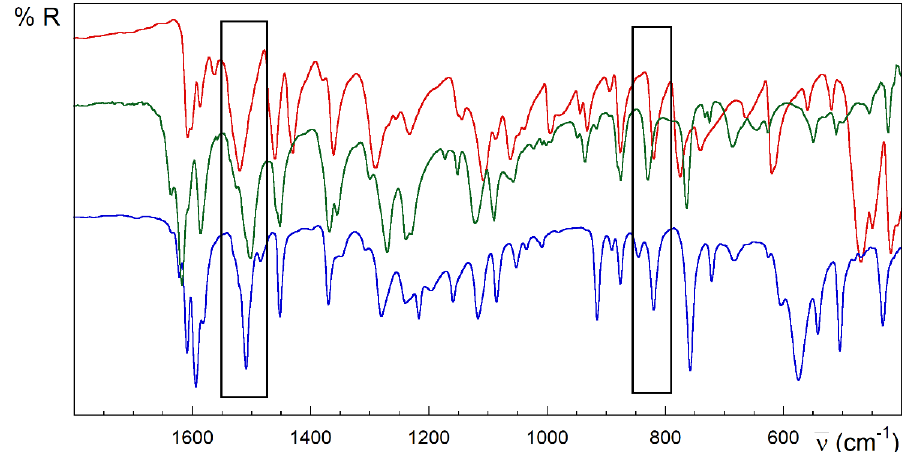
Figure 5. FTIR-ATR spectra of HL (red), (H 2 L)Cl · H 2 O (green) and 4 (blue). Rectangles in black show bands in the same spectral regions for the three compounds.